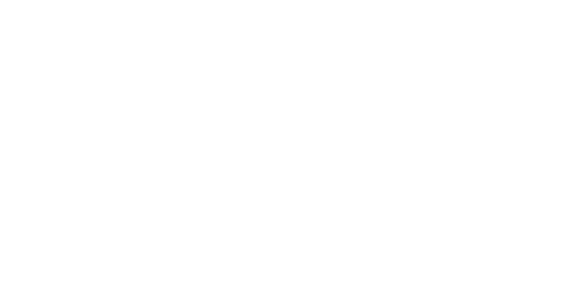
Table 2. Main parameters of impeller.